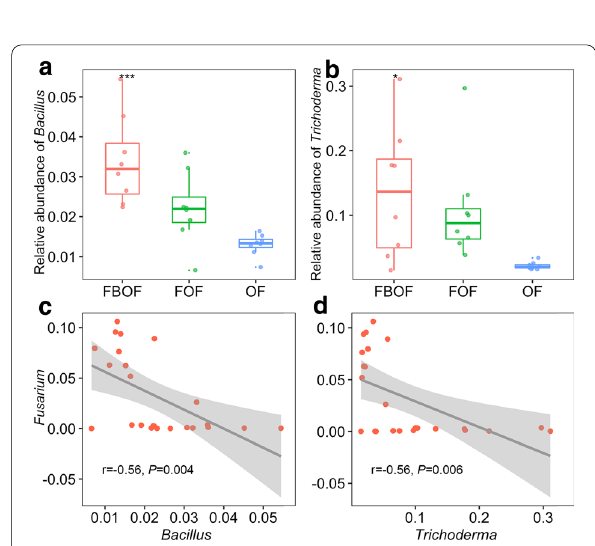
Fig. 3 The relative abundance (RA) of genus Bacillus ( a ) and Trichoderma ( b ) in the three treatments and Pearson correlations (r) between RA of Bacillus ( c ) and Trichoderma ( d ) with RA of Fusarium . The asterisk indicates significant differences among the treatments, as defined by Duncan test ( P < 0.05). OF organic fertilizer, FOF dazomet fumigation followed by organic fertilizer, FBOF dazomet fumigation followed by biological organic